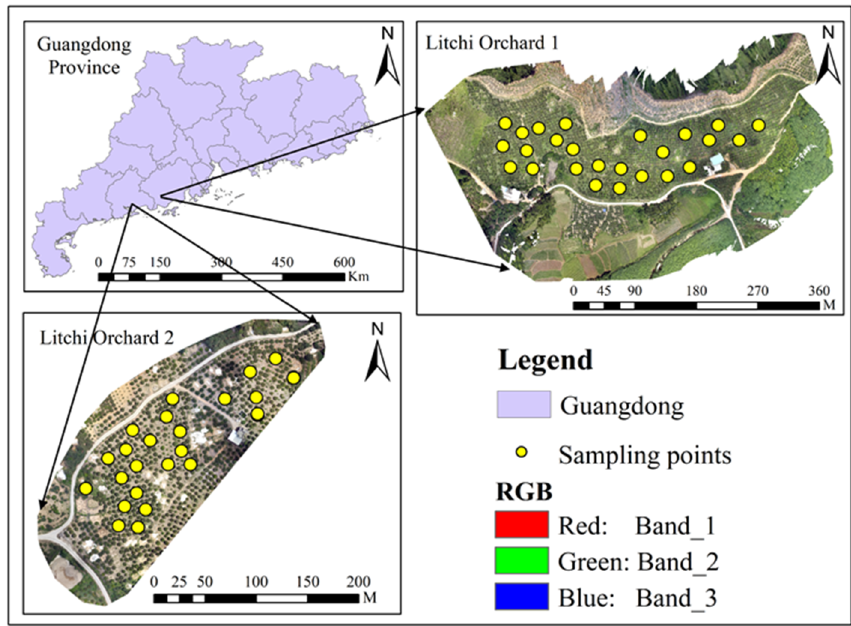
Figure 4. Distribution of sampling sites in Guangdong Province of China. Litchi orchard 1: Yangxi County, Yangjiang City; Litchi orchard 2: Dianbai District, Maoming City.